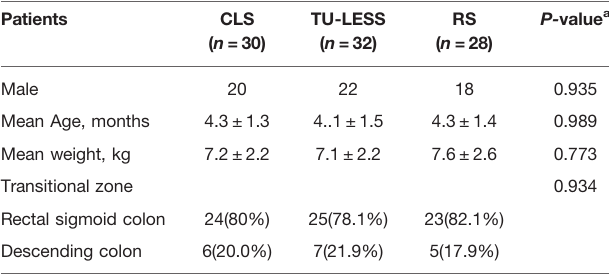
FIGURE 1 | The pictures of homemade glove port ( A ) and multi-instrument laparoscopic ports ( B ) in the TU-LESS,